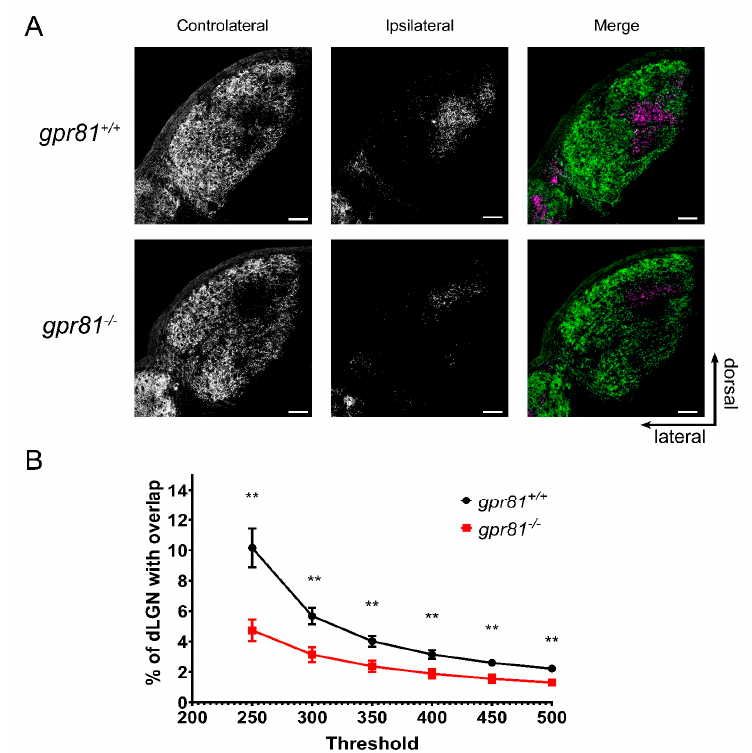
Figure 5. GPR81 Affects Retinothalamic Projections in vivo. ( A ) Micrographs of the dorsal lateral geniculate nucleus (dLGN) following the injection of CTb-Alexa 555 in the left eye and CTb-Alexa 647 in the right eye of gpr81 +/+ and gpr81 − / − mice. Controlateral and ipsilateral projections from both